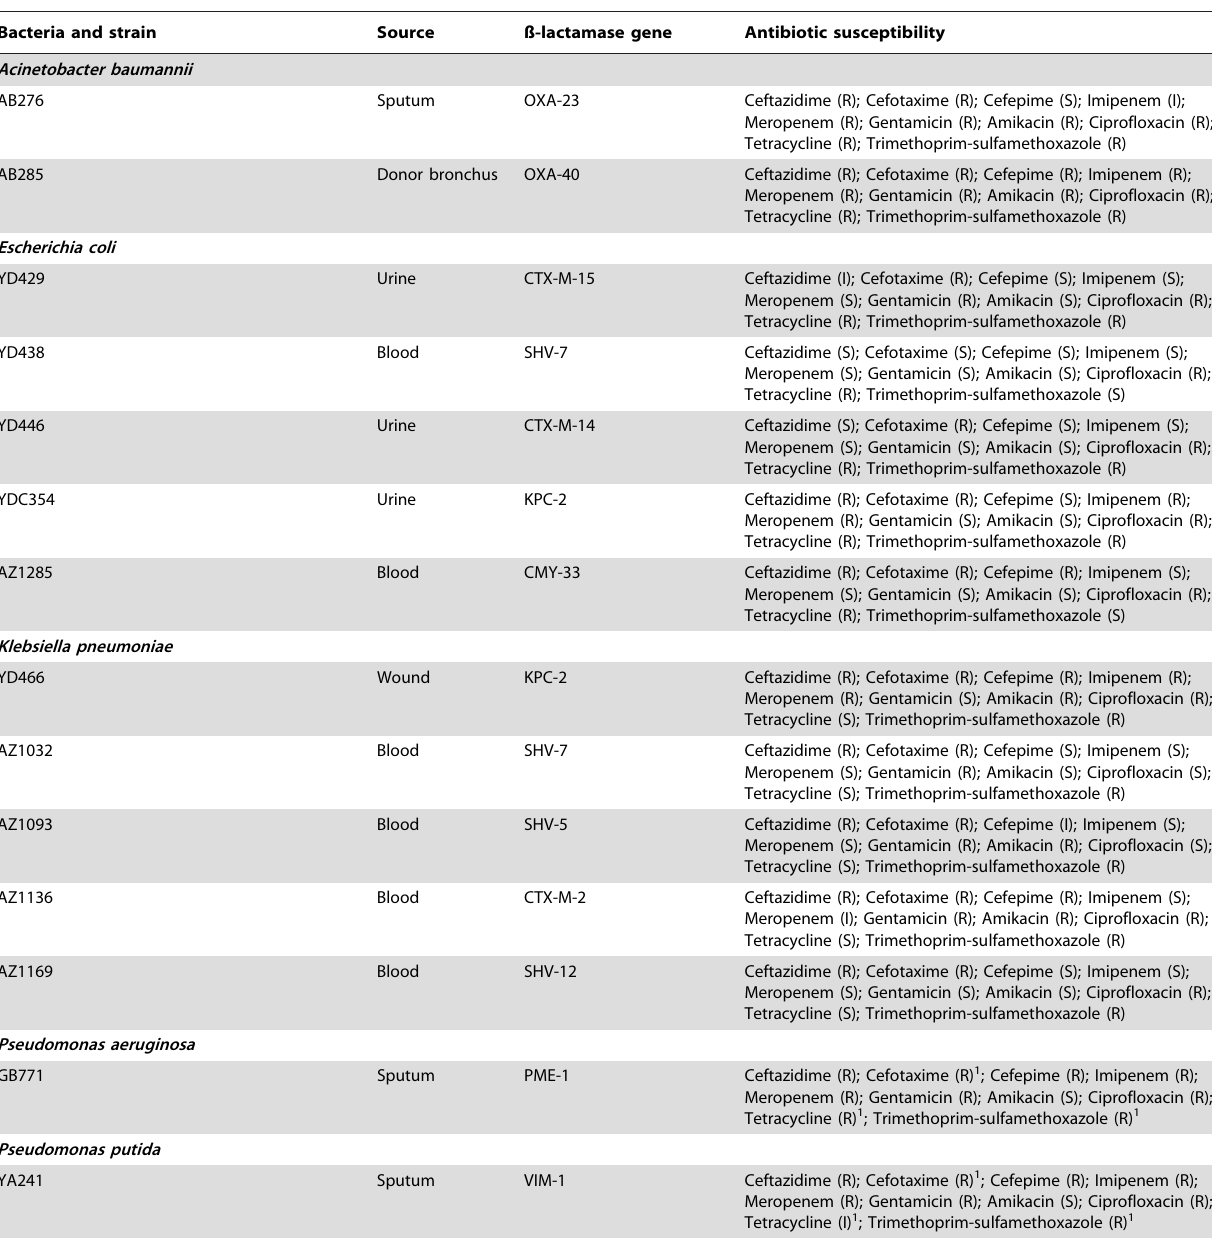
Table 1. Host pathogens used in the study and their antibiotic susceptibility.